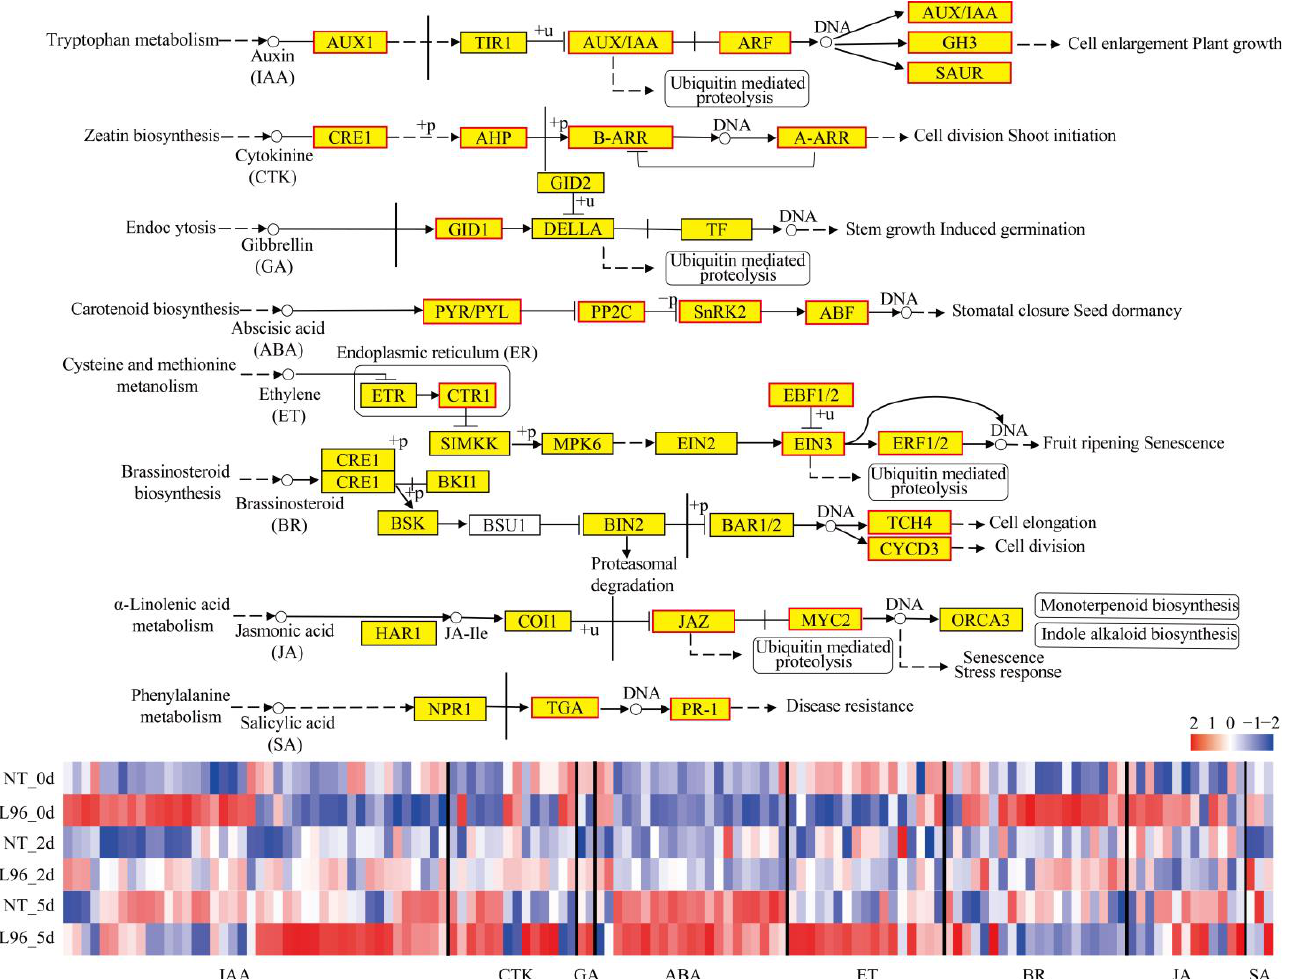
Figure 4. Plant hormone signal pathway activated by L96 and NT under salt stress. Heatmap shows FPKM values in each treatment, normalized using z-score.